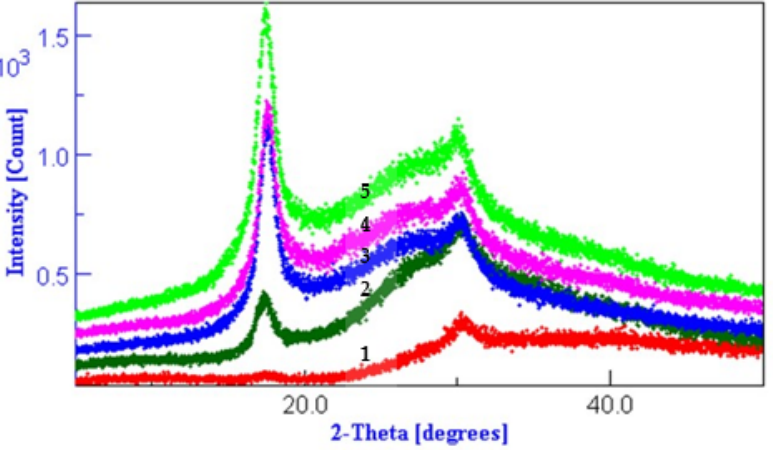
Figure 4. Diffractograms of Dralon L treated at 120 °C for 60 min: ( 1 ) control sample, ( 2 ) boiled in water, ( 3 ) 6% KOH, ( 4 ) 6% KOH plus 6% I 2 /KI, and ( 5 ) 6% KOH plus 6 %